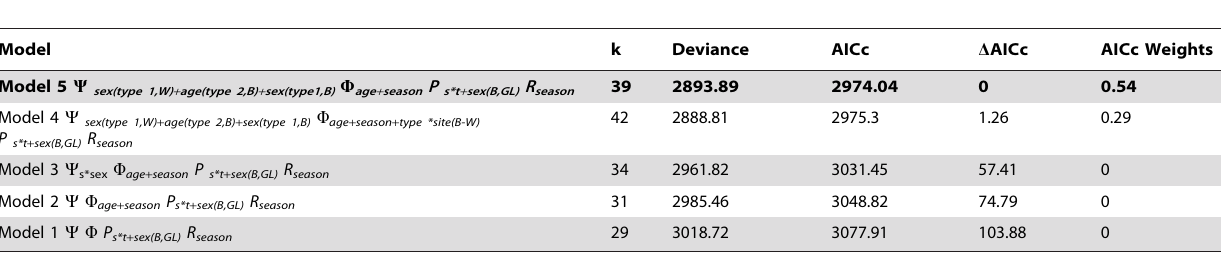
Table 1. Model selection for multi-event CMR models of probability of presence on Grand-Lieu ( Y ) and survival ( W ) of pochards ringed on Grand-Lieu (France).